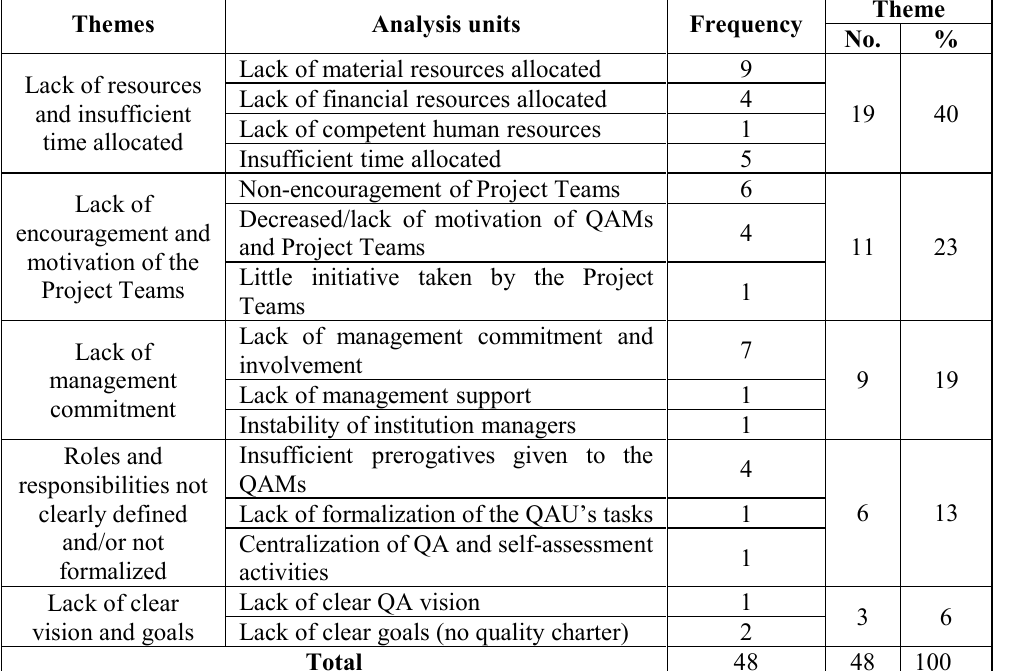
Table 2. Interview Content Analysis Grid (developed by the authors)